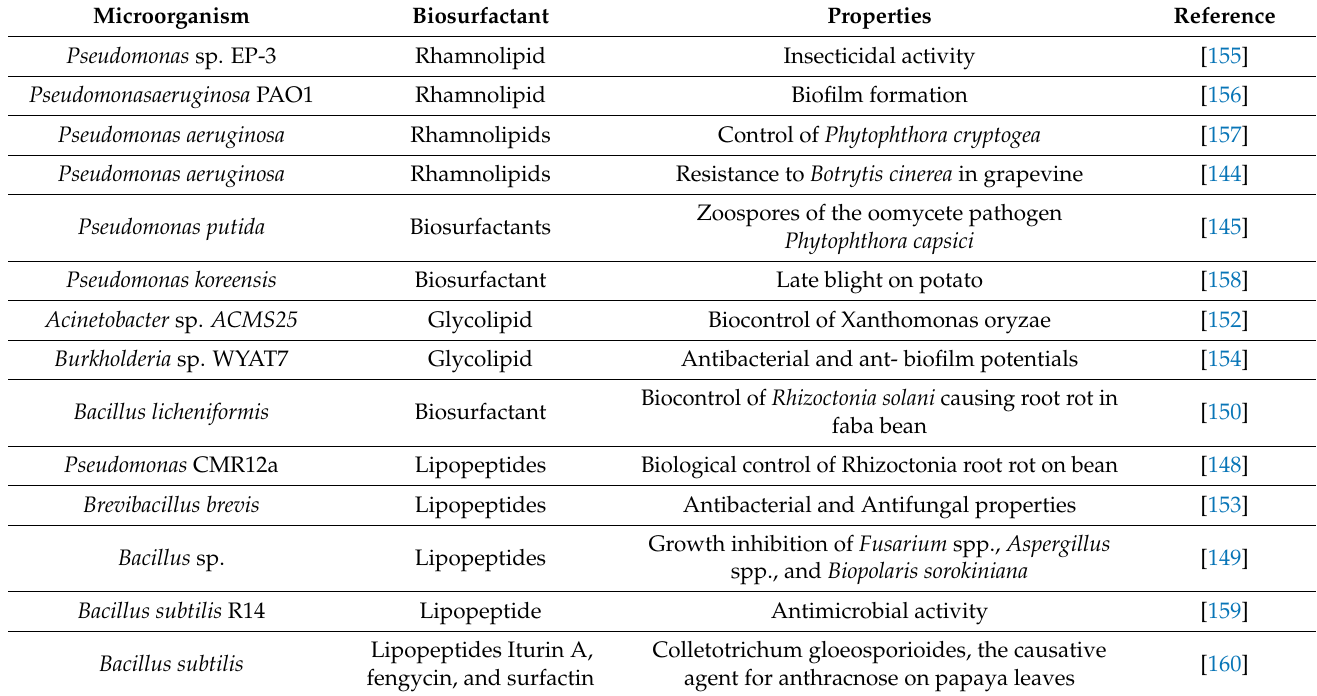
Table 5. The common biosurfactants used in plant disease